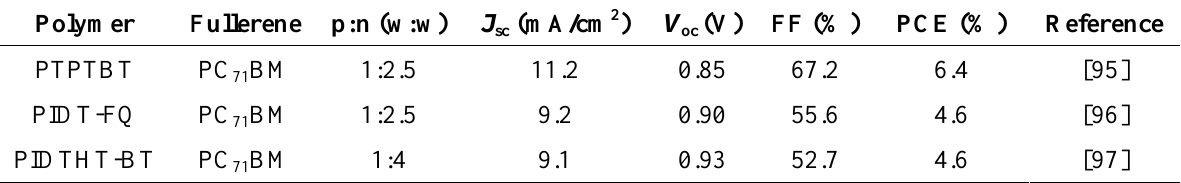
Table 2. IDT-based 2D conjugated polymers for